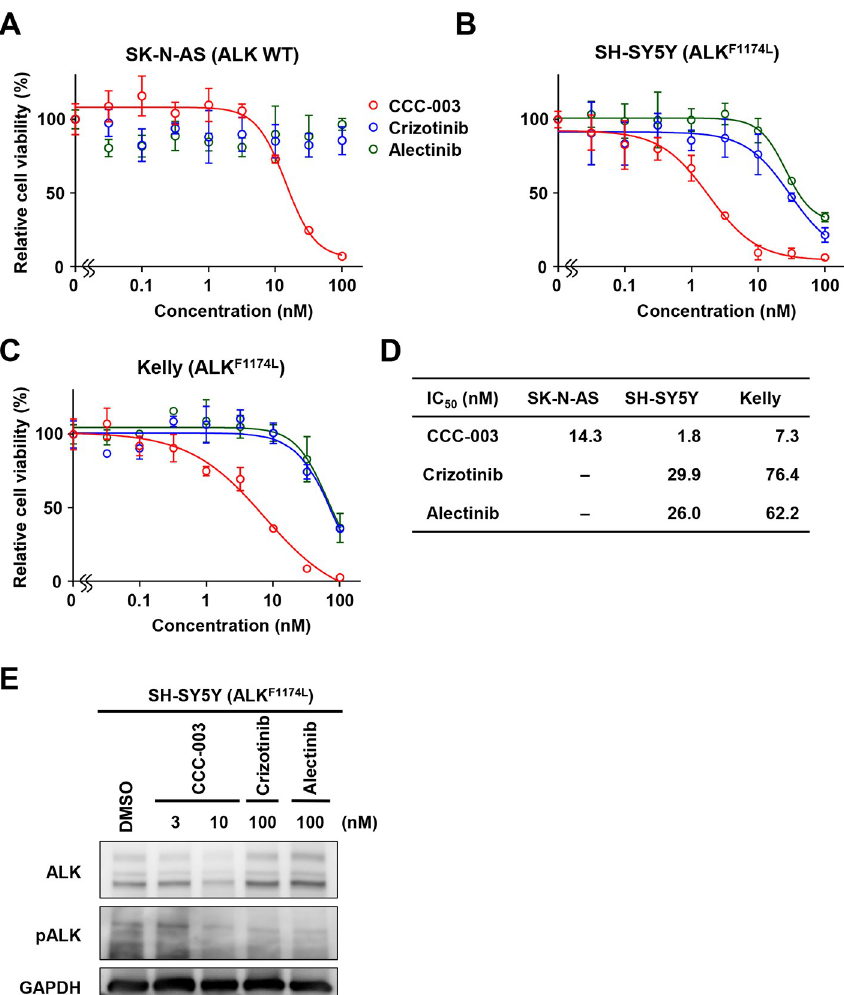
Fig 3. CCC-003 inhibits cell proliferation and ALK expression in ALK -mutated neuroblastoma cell lines to a greater extent than other ALK inhibitors. (A, B, C) WST assay in ALK wild-type and ALK -mutated cells. (A) SK-N-AS cells were incubated for 72 h after treatment with CCC-003 or ALK inhibitors crizotinib and alectinib. (B) SH-SY5Y cells were incubated for 72 h after treatment with CCC-003 or ALK inhibitors. (C) Kelly cells were incubated for 72 h after treatment with CCC-003 or ALK inhibitors. (D) IC 50 values of CCC-003, crizotinib, and alectinib. (E) SH-SY5Y cells were treated with 3–10 nM CCC-003 or 100 nM ALK inhibitors for 72 h. ALK and pALK protein levels were determined using western blotting